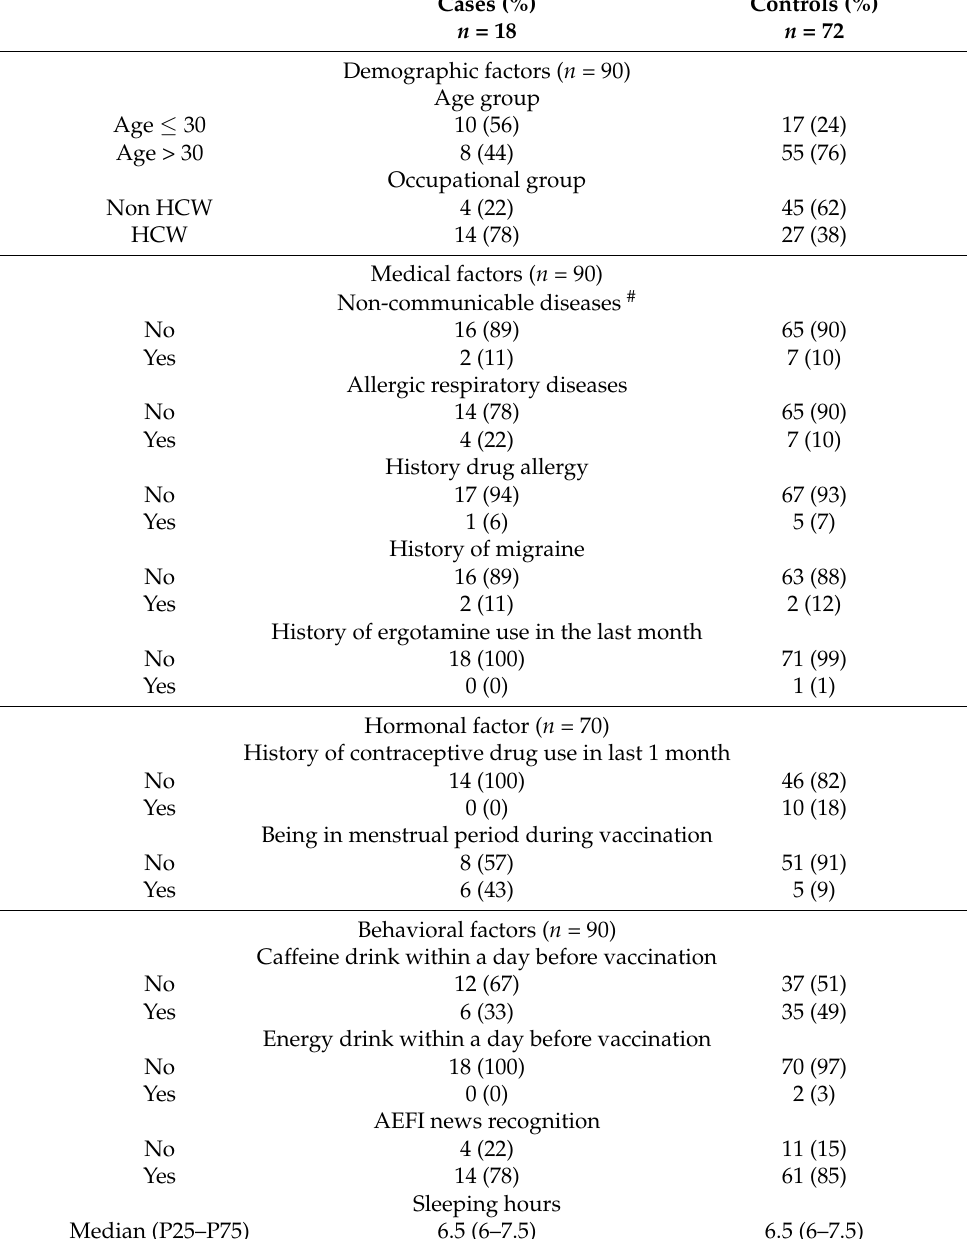
Table 3. Characteristics of ISRR cases and matched controls §